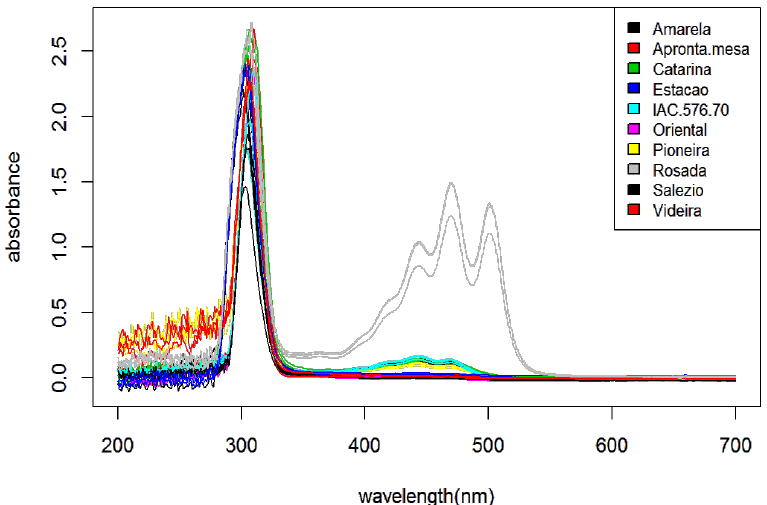
Figure 1: Typical UV-Vis spectrophotometric profiles ( λ = 200-700 nm, acetone: petroleum ether - v/v) of root parenchymal tissues of ten cassava genotypes cultivated in southern Brazil.